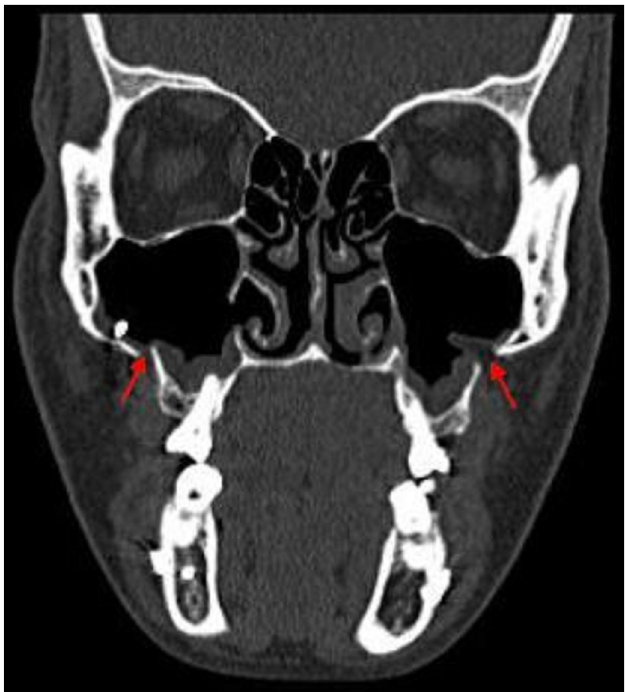
Fig. 5. Postoperative coronal CT image showing persistent unilateral maxillary sinusitis on left side (arrow).